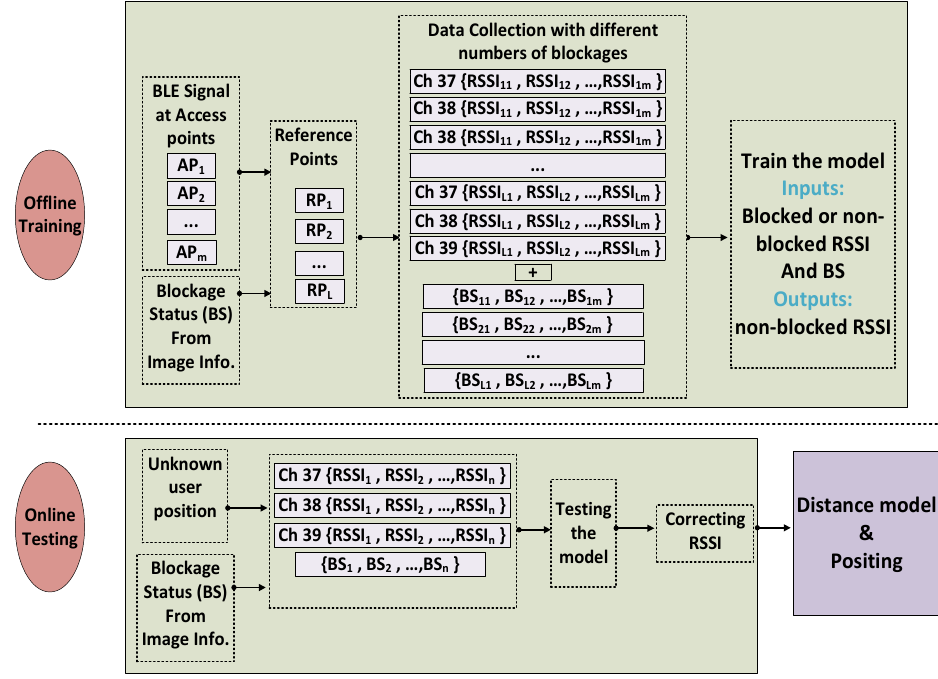
Figure 7. Schematic diagram of the proposed approach.